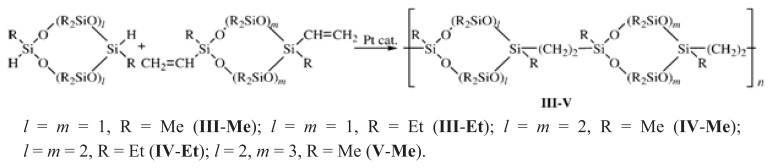
Synthesis of CL PMCS III–V.